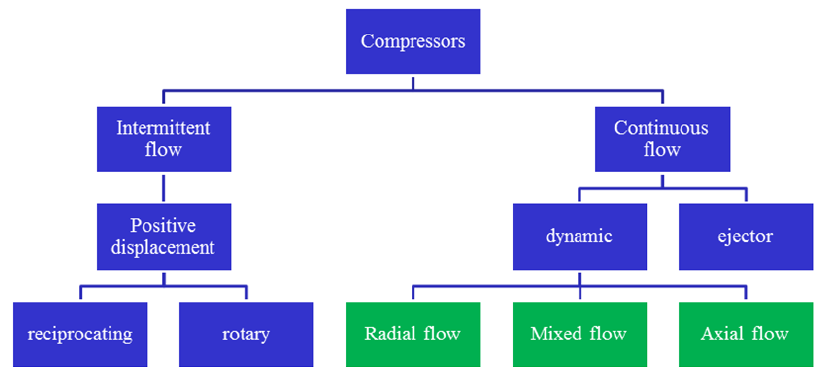
Figure 8. Compressor types.